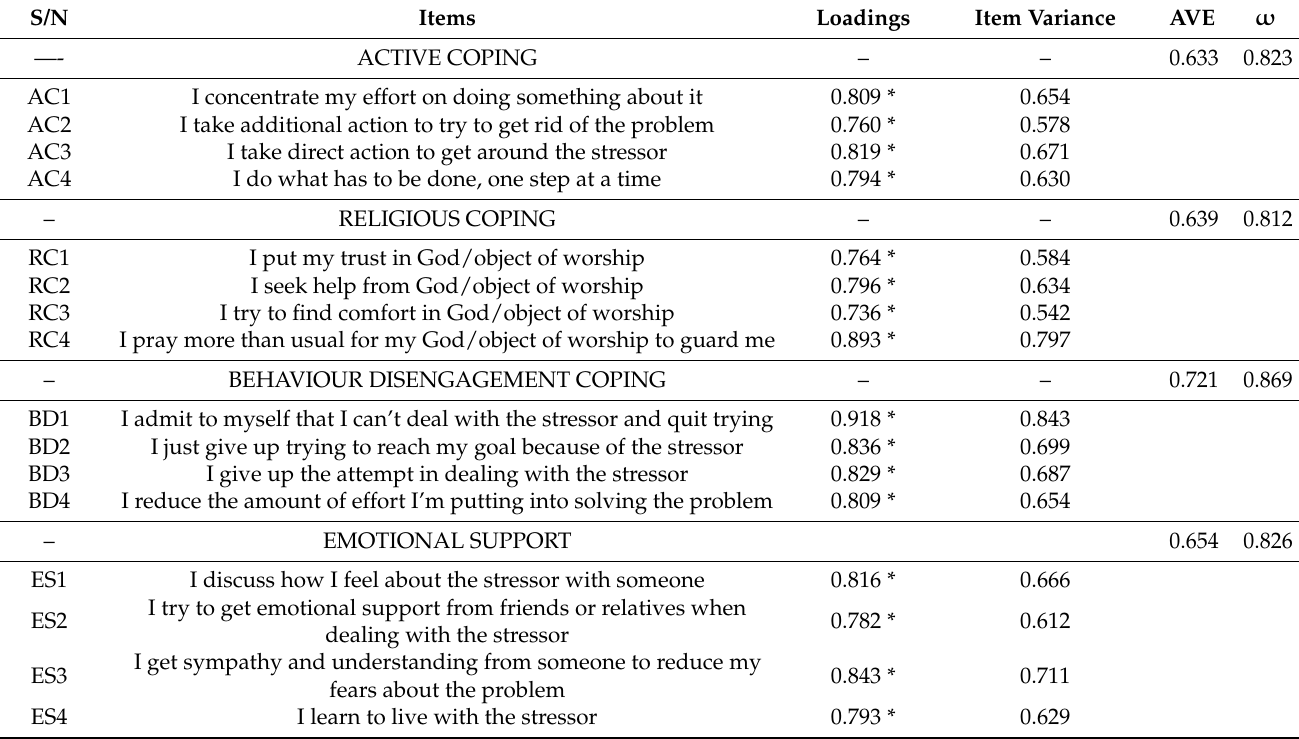
Table 2. Item Loadings, Variances, AVE and Reliability